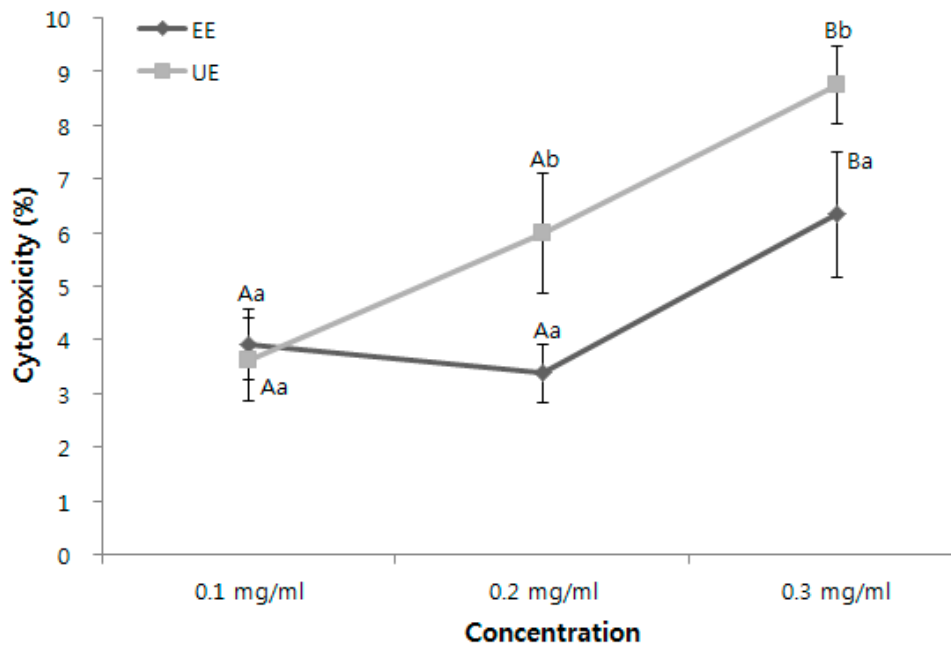
Figure 1. Cytotoxicity of the E. prostrata L. extracts against human skin fibroblasts (CCD-986sk). Mean values ± Standard Deviation (SD) from triplicate separated experiments are shown. Means with different letters (A–B) within the same sample are significantly different at p < 0.05 and means with different letters (a–b) within the same concentration are significantly different at p < 0.05. (1) EE: 70% ethanol extraction at 80 °C, (2) UE: ultrasonic extraction with 70% ethanol at 40 °C.